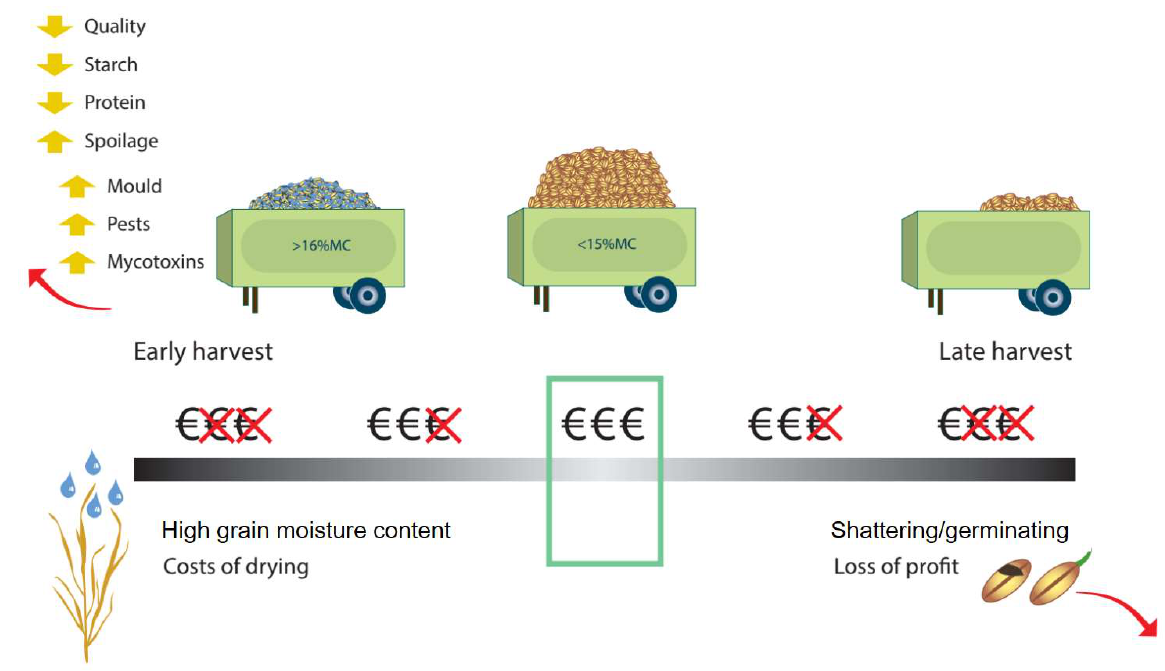
Figure 10. Factors controlling harvest and grain store losses.